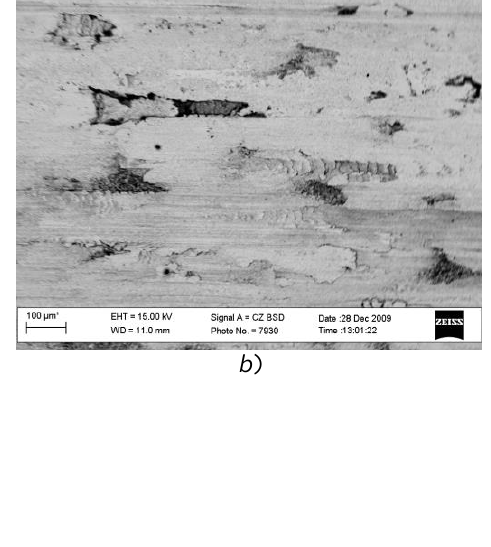
Fig.5. Toporaphy of friction surfases CEC Ni-B after tribocorrosion investigations in glycerin + 10% NaCl: ( a ) without thermal treatment, after vacuum annealing at 300  С ( b ) and 450  С ( c